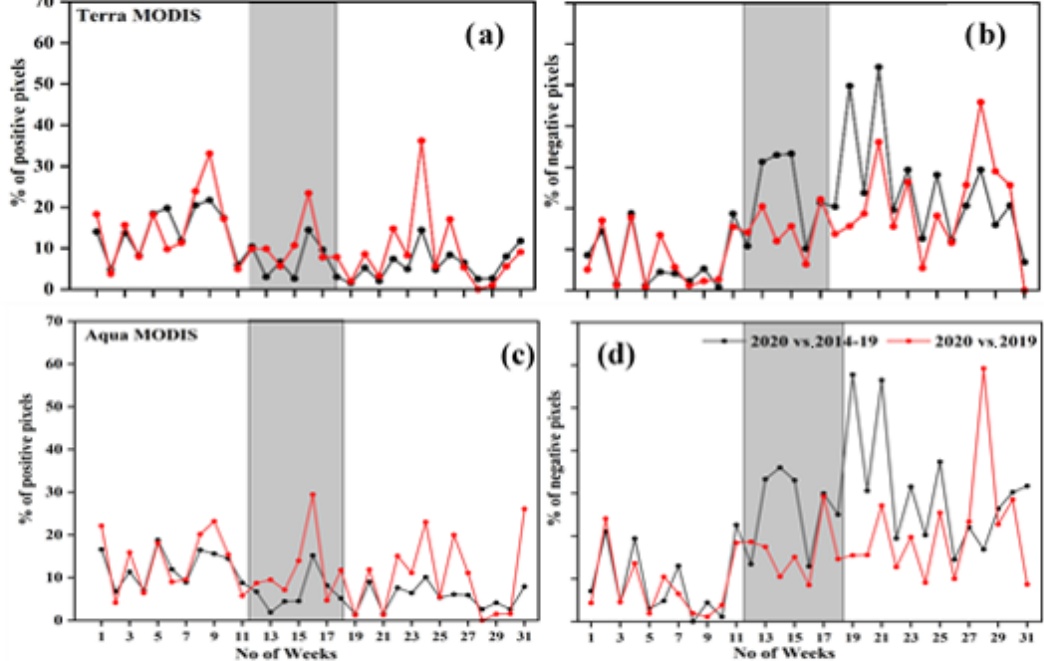
Figure 9. Terra MODIS (a) percentage of number of positive pixels, and (b) percentage of number of negative pixels during the period 2020 vs. (2014–2019) and 2020 vs. 2019. Aqua MODIS (c) percentage of positive pixels and (d) percentage of negative pixels during the period 2020 vs. (2014–2019) and 2020 vs.